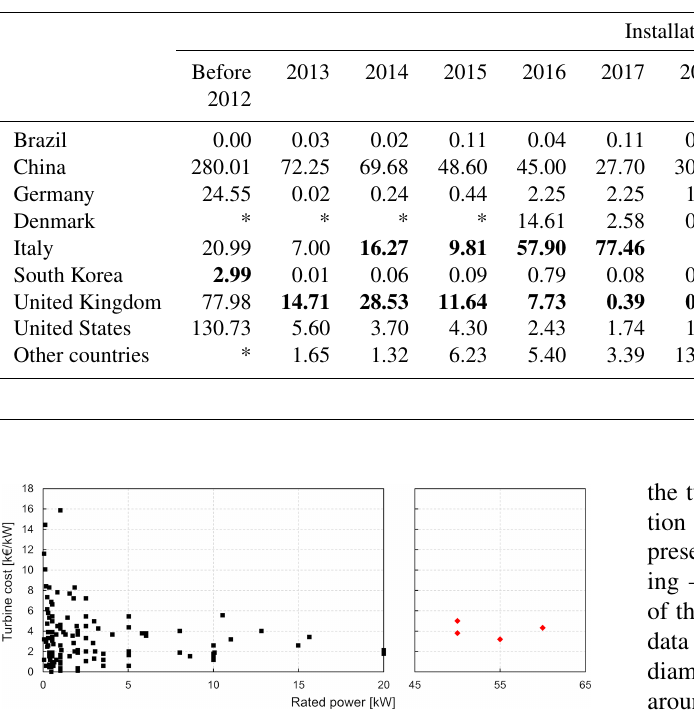
Table 1. Small wind turbine installations through 2020. Data from Orrell et al. (2021) and Chagas et al. (2020). Values in bold refer to years/countries with FIT schemes in place. Asterisks refer to missing data for that specific year.